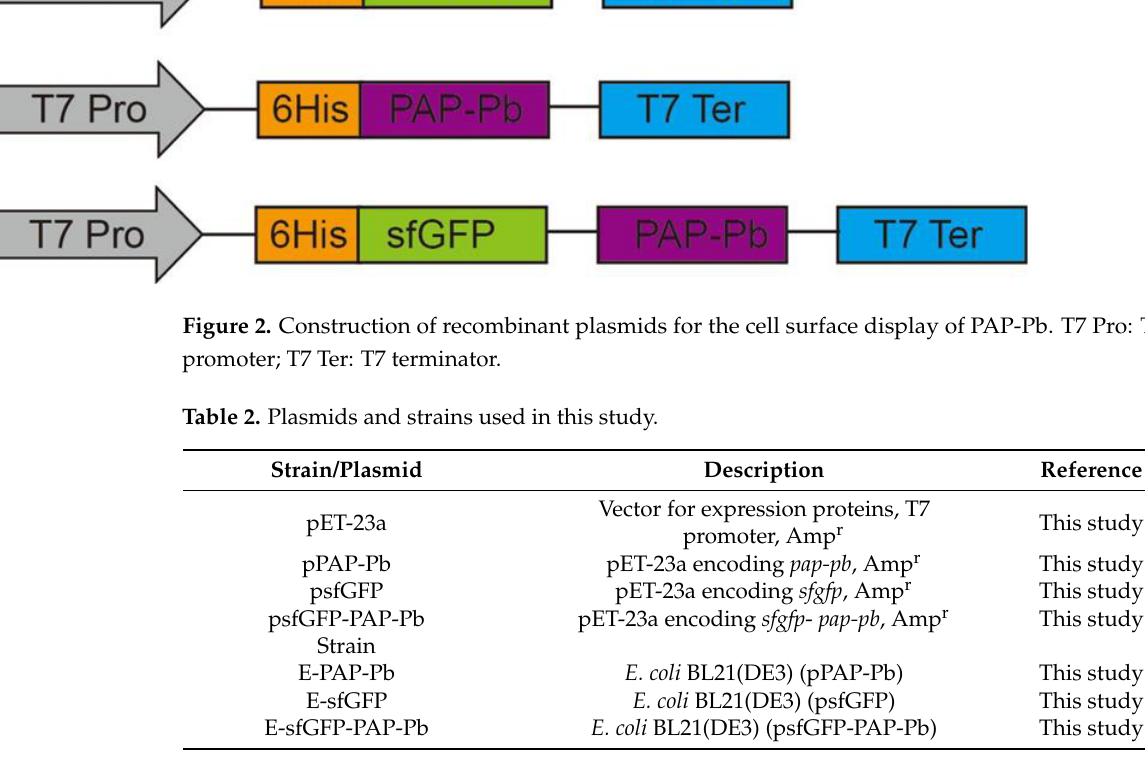
Table 2. Plasmids and strains used in this study.